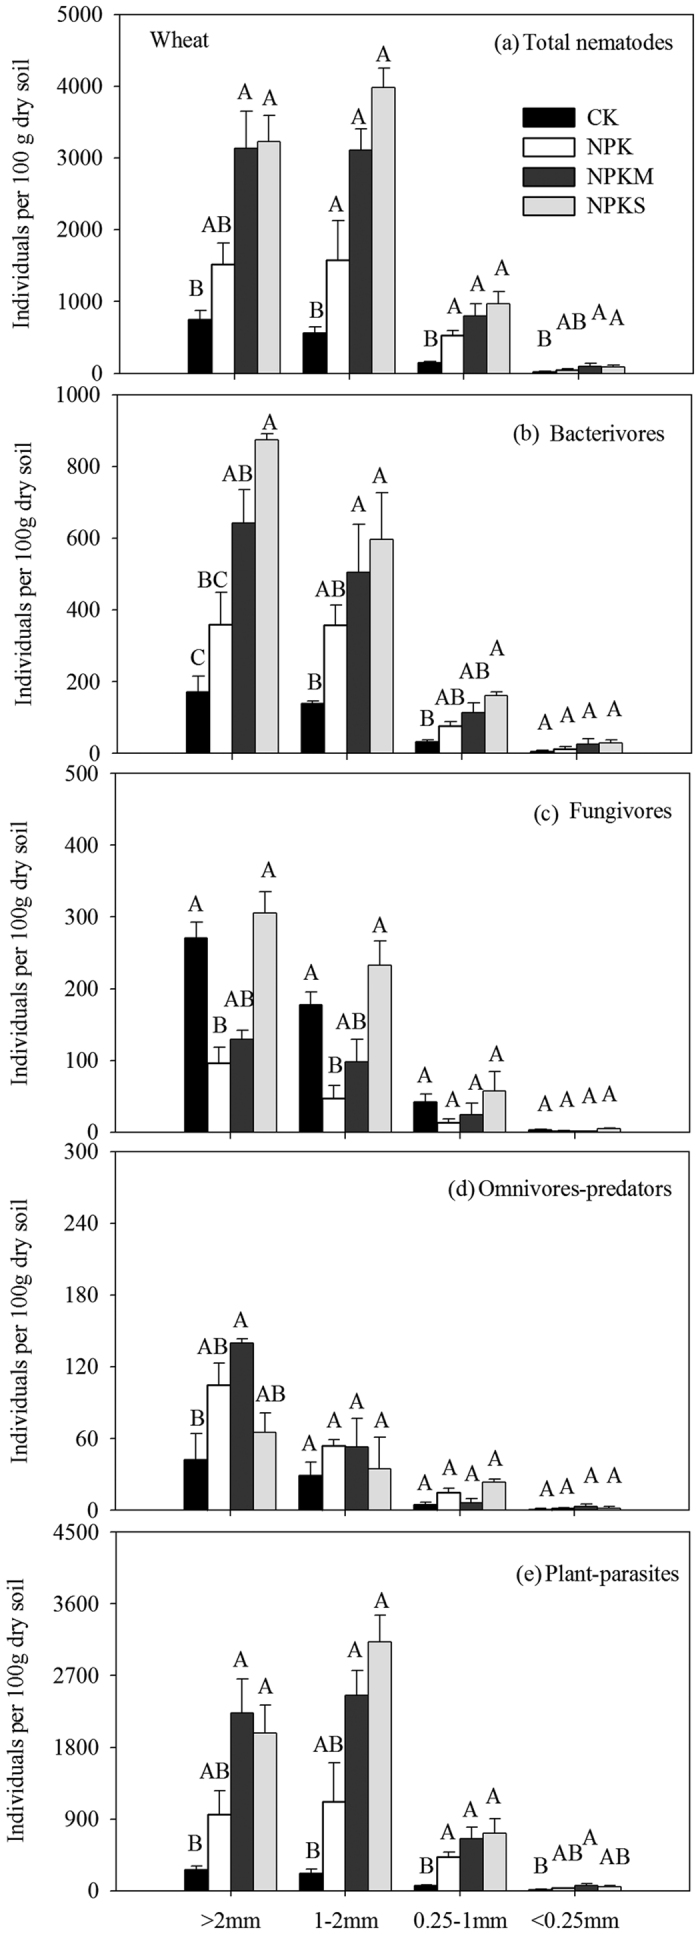
Abundances of total nematodes and different trophic groups within aggregates under different fertilization treatments.Bars indicate standard error (n = 3). Different capital letters (A,B etc.) show significant differences among different treatments for each aggregate size, respectively, as determined by Tukey’s honestly significant difference test, P < 0.05.